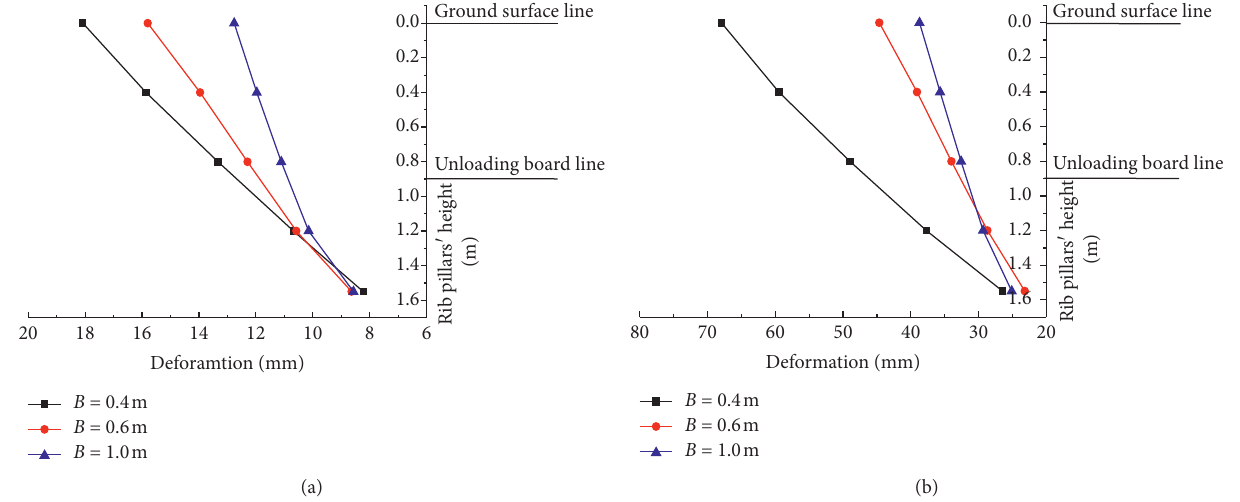
Figure 11: The variation curve of the deformation of rib pillars with the wall body at the external load: (a) h � 0.9m ( p � 10kPa) and (b) h � 0.9m ( p �